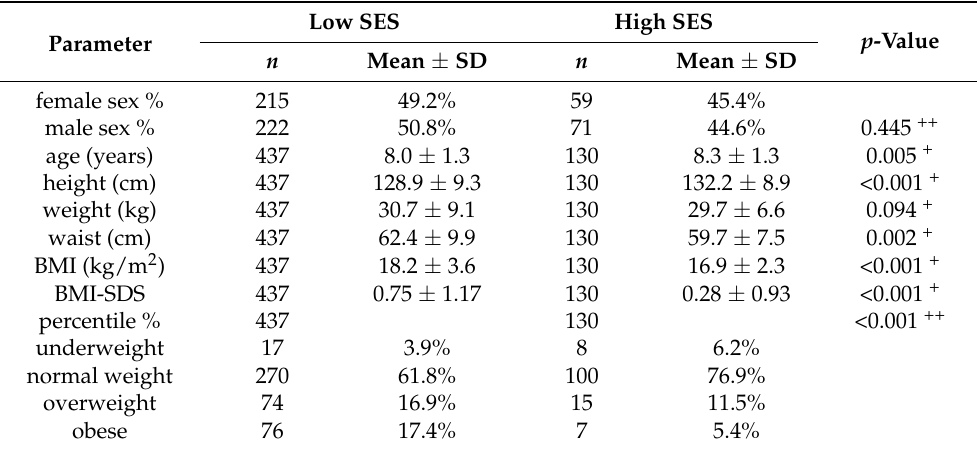
Table 4. Descriptive statistics of anthropometric data broken down by